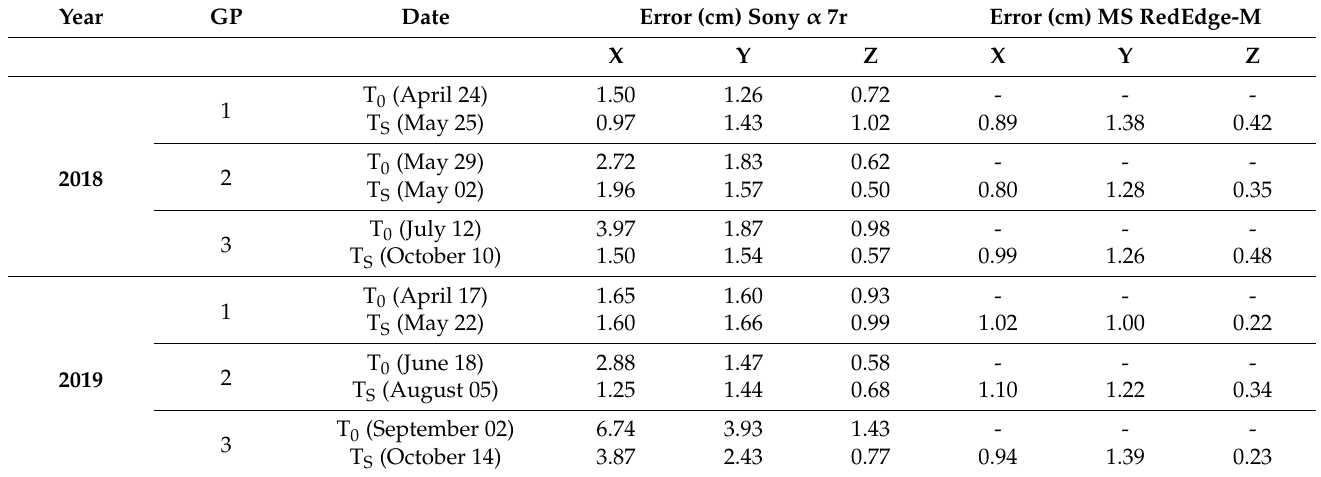
Table 6. Error report of the photogrammetric data processing in Metashape for each UAV campaign: Sony Alpha 7r for canopy height feature’s calculation; MicaSense Rededge-M for spectral